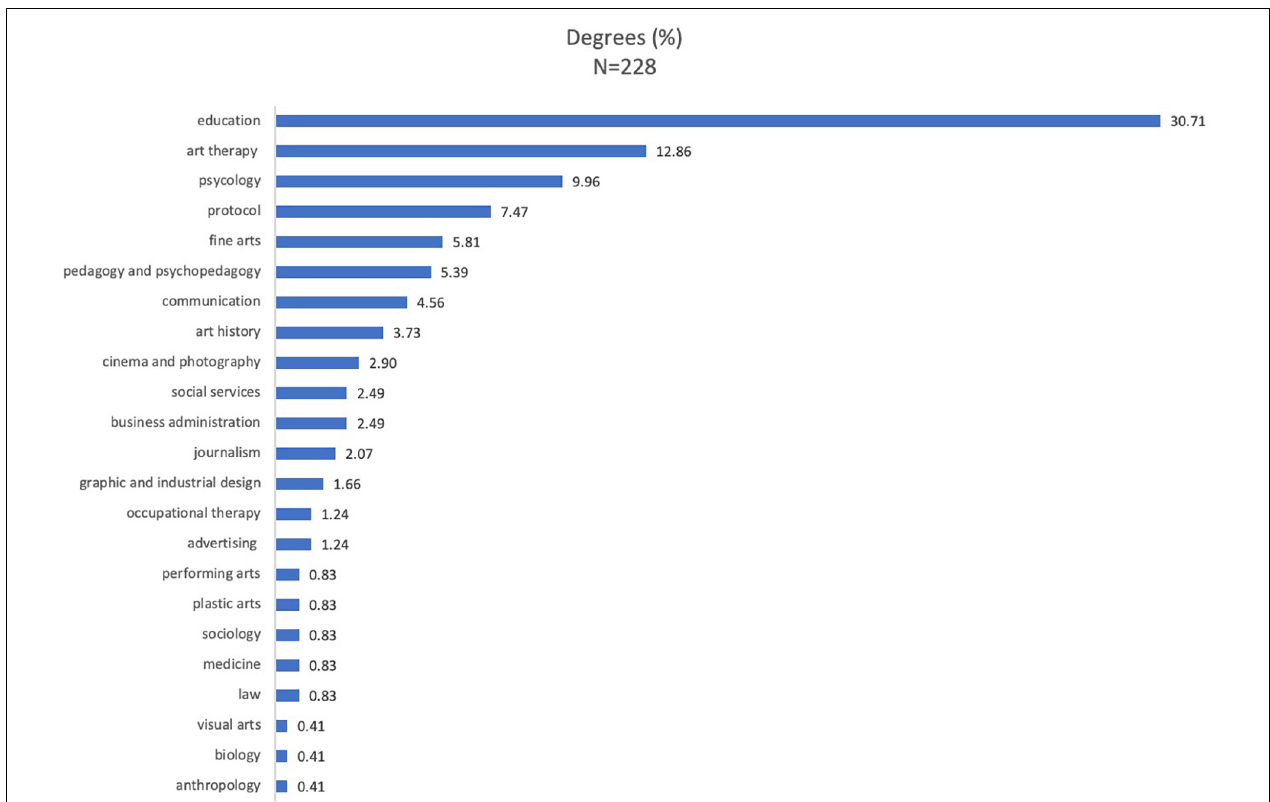
FIGURE 5 | Percentage of questionnaire participants by career